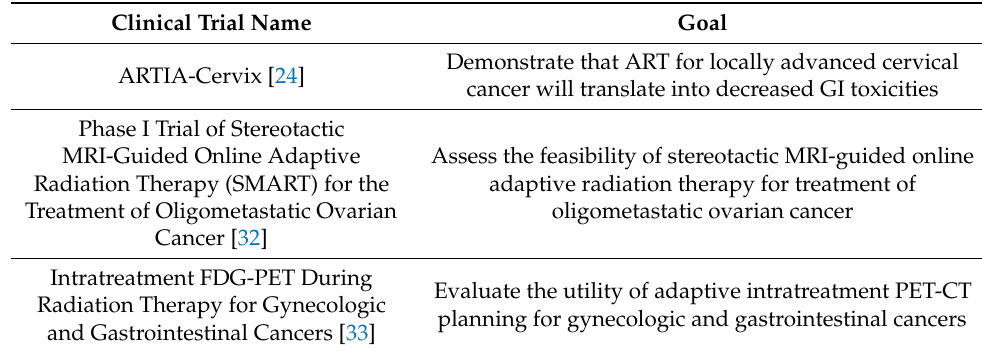
Table 1. Ongoing clinical trials utilizing online ART.